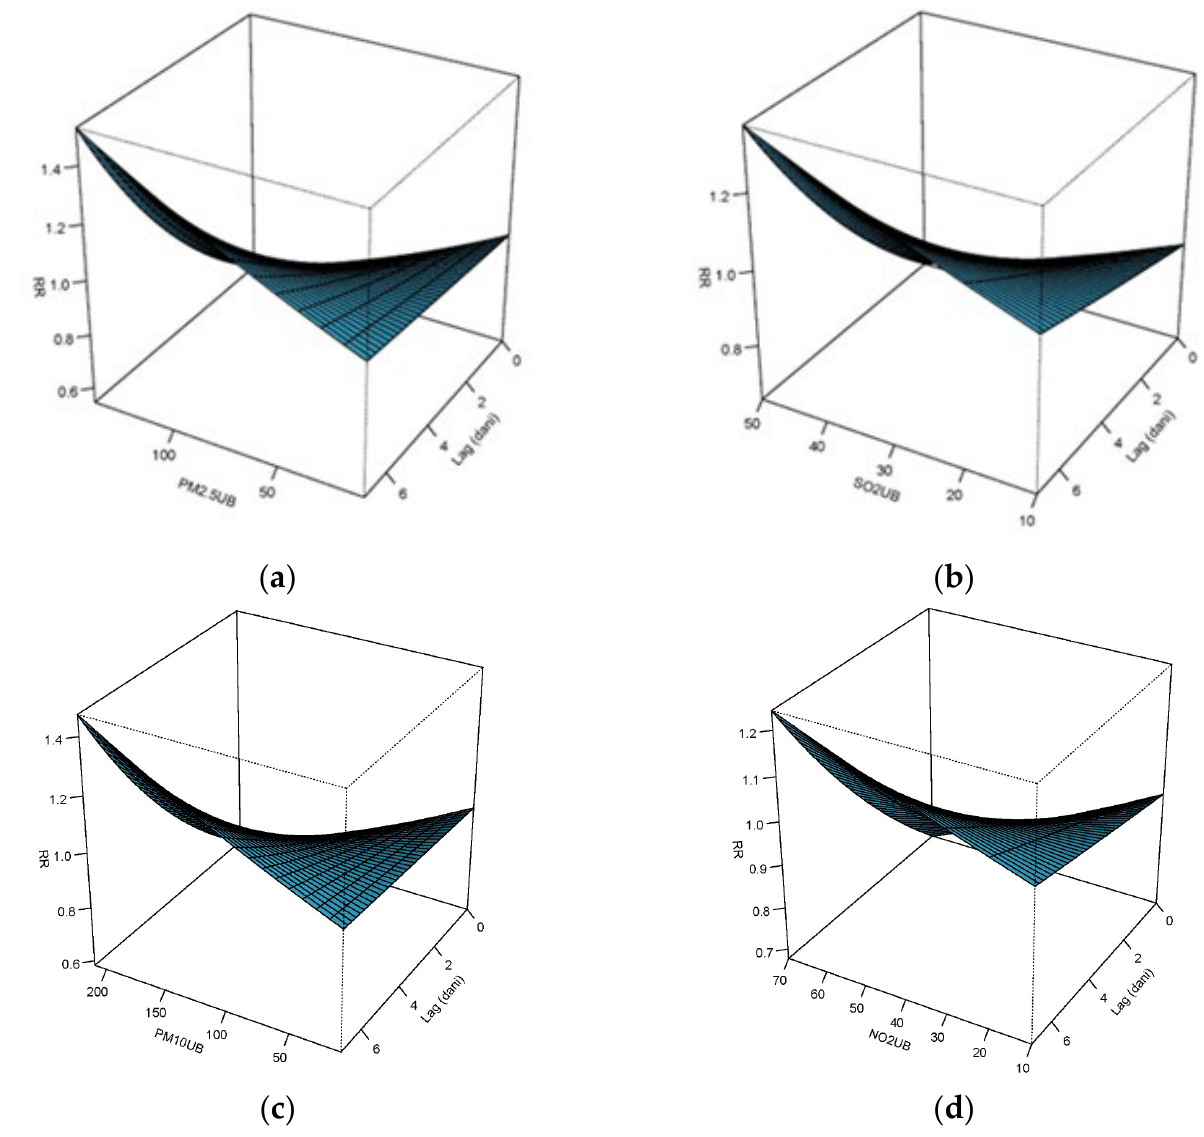
Figure 4. Lag effects of air pollutants on AECOPD hospitalization: ( a ) PM 2.5 UB; ( b ) SO 2 UB; ( c ) PM 10 UB; ( d ) NO 2 . On these bi-dimensional figures, RR is represented on the vertical axis, with the minimal value of 0. On the first horizontal axis, the concentrations of air pollutants are disposed (lower concentration on the right, higher on the left), while on the other horizontal axis, lags are presented (lower lag on the right, higher on the left).